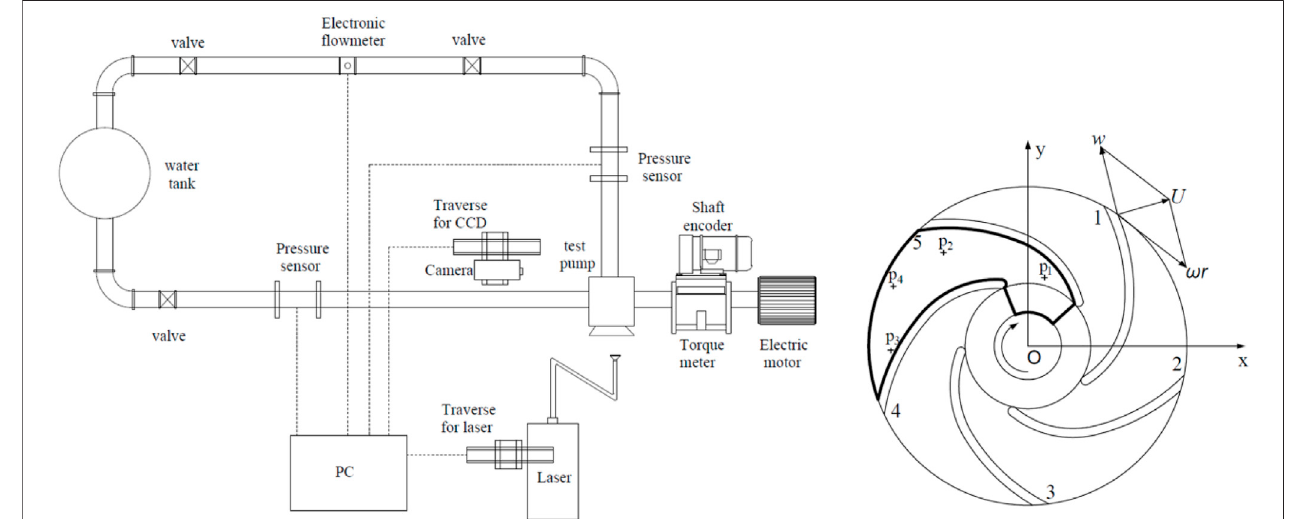
FIGURE 1 | Test impeller.